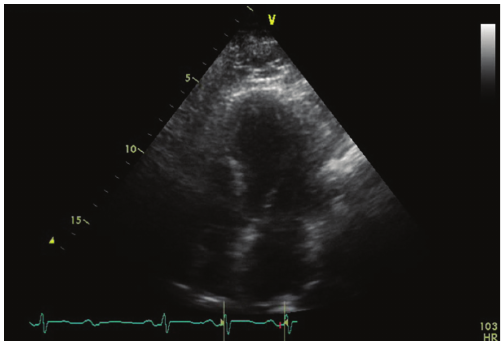
Figure 4: Transthoracic echocardiogram. The patient’s transtho- racic echocardiogram in diastole showing neurogenic stunned my- ocardium. Apical four-chamber view showing left ventricle, left atrium, and mitral valve during diastole. Note the uniformity of the endomyocardium resulting in a “bullet shape” of the left ventricle in which all three segments of the ventricle: base, mid, and apex relax